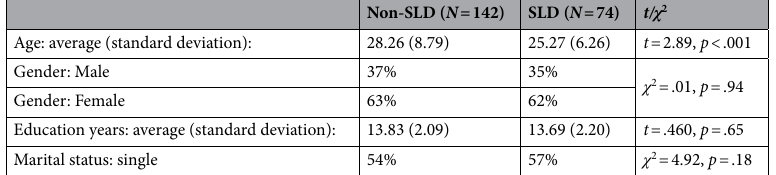
Table 1. Characteristics of participants in Non-SLD and SLD